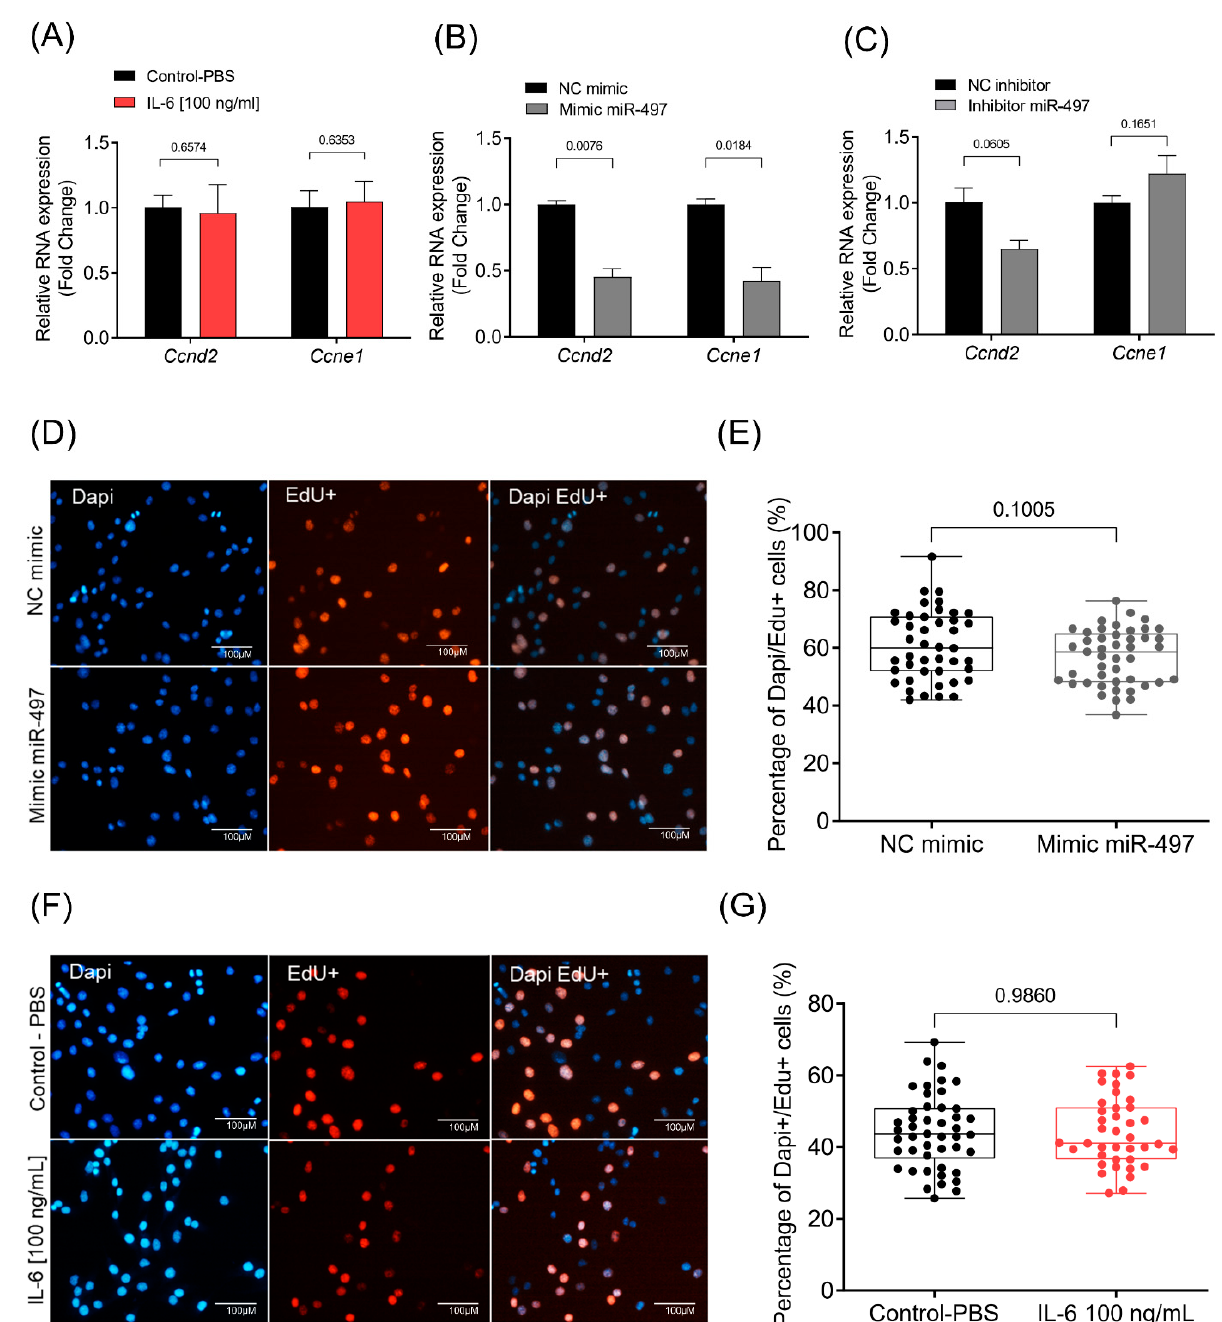
Figure 6. miR-497-5p and cellular proliferation. mRNA levels of the cyclins CcnD2 and CcnE1 in C2C12 myoblasts treated with IL-6 [100 ng/mL] or PBS ( A ) transfected with miR-497-5p mimic or negative control ( B ) and transfected with miR-497-5p inhibitor or negative control. ( C ) RT-qPCR data are presented as fold change (2 − ∆∆ Ct ) relative to Rpl13a . ( D ) Representative images of myoblasts transfected with miR-497-5p mimic or negative control. Cells were stained with EdU (red). ( E ) Percentage of Dapi (blue), and Edu+ cells from the total Dapi cells. ( F ) Representative images of myoblasts treated with IL-6 (100 ng/mL) or PBS (control) and stained with EdU (red). ( G ) Percentage of Dapi (blue), and Edu+ cells out of the total Dapi cells. Data represent the average of three independent experiments with standard deviation. Statistical difference was analyzed by Student’s t -test.